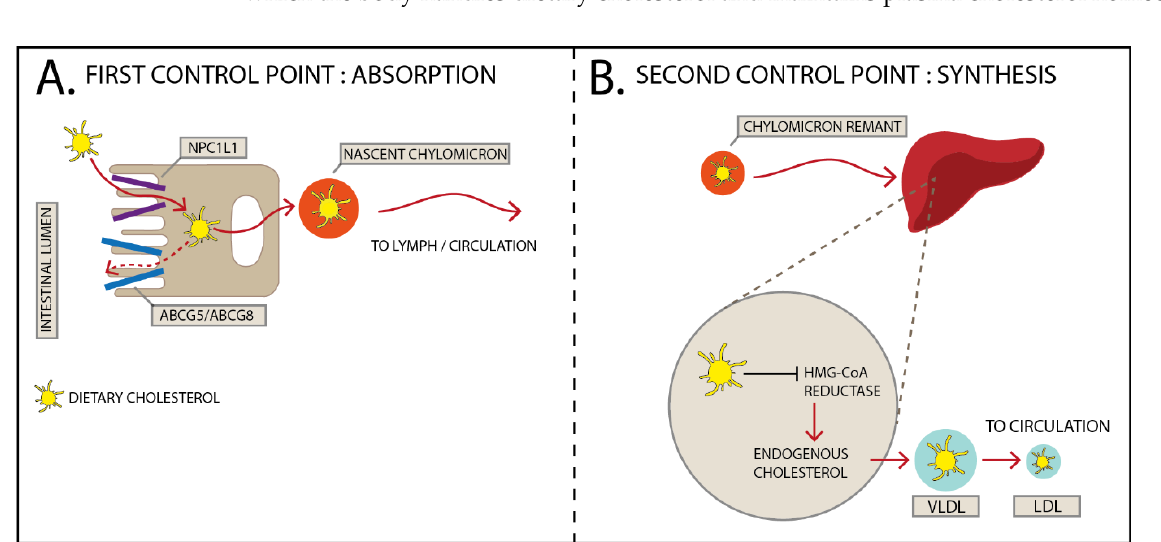
Figure 1. Mechanisms of how dietary cholesterol affects cholesterol metabolism. ( A ) Dietary choles- terol enters the enterocyte via NPC1L1 after being released from the micelle. However, some choles- terol is effluxed back to the intestinal lumen via ABCG5 and ABCG8 transporters explaining why only a percentage of the cholesterol consumed in the diet reaches the bloodstream. The remaining cholesterol gets packed into nascent chylomicrons, which enter the lymph and then the systemic circulation. ( B ) After losing most of its triglycerides, the cholesterol-loaded chylomicron remnant is removed by the liver. In the liver, free cholesterol inhibits HMG-CoA reductase, the rate limiting enzyme for endogenous cholesterol synthesis, Thus, if more cholesterol is consumed, less will be synthesized by the hepatocytes. VLDL: very-low-density lipoprotein; LDL: low-density lipoprotein; NPC1L1: Polytopic Niemann-Pick C1-like 1; ABCG5/ABCG8: ATP-binding cassette transporters G5/G8; HMG-CoA: 3-hydroxy-3-methyl glutaryl coenzyme